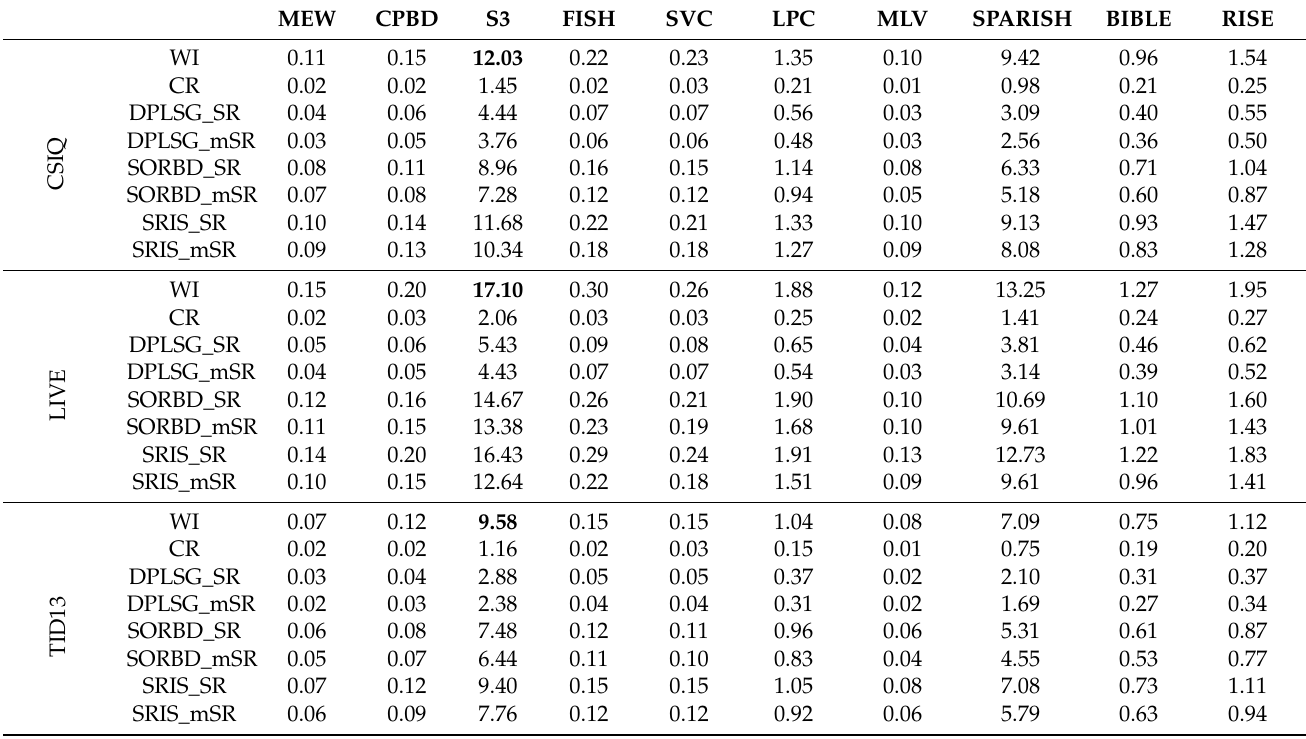
Table 6. Average time cost per input on image sharpness assessment